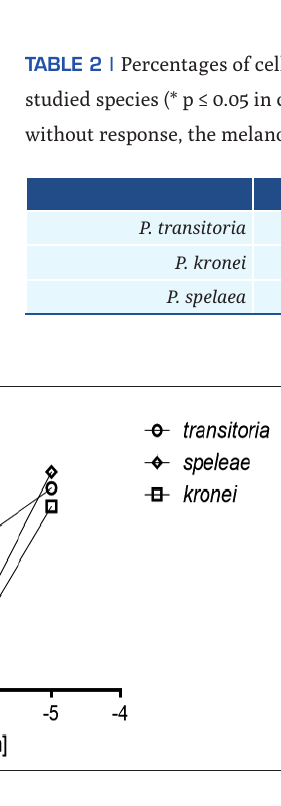
FIGURE 1 | Dose-response curves for Adrenalin in melanophores of the species of Pimelodella . Each point is the mean ± SEM ( P. transitoria , n = 6, P. speleae , n = 7, and P. kronei , n = 8). * statistically different (p≤ 0.05). Control – melanosomes fully dispersed.